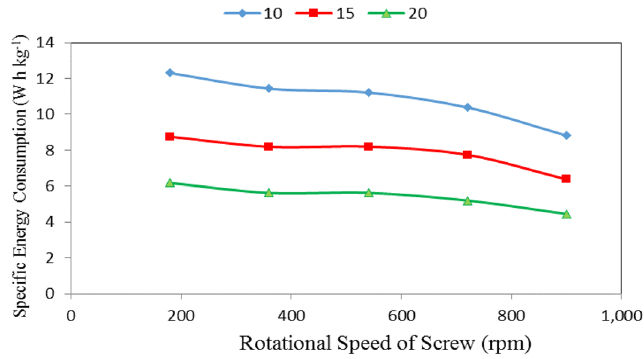
Figure 12. Specific energy consumption at different rotational speeds of screw and air flow